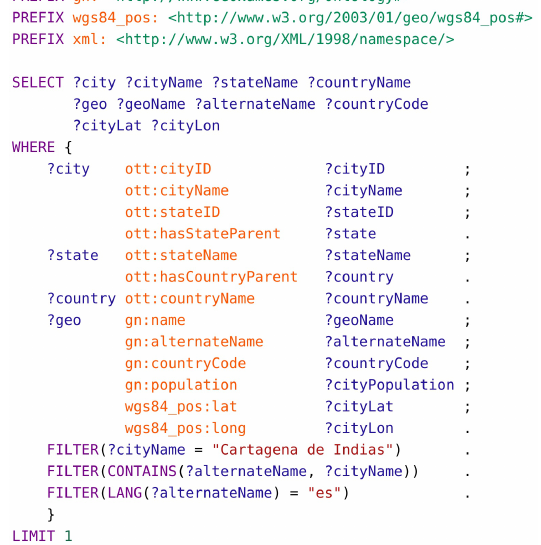
Figure 6. Listing of Data link to GeoNames for obtaining city